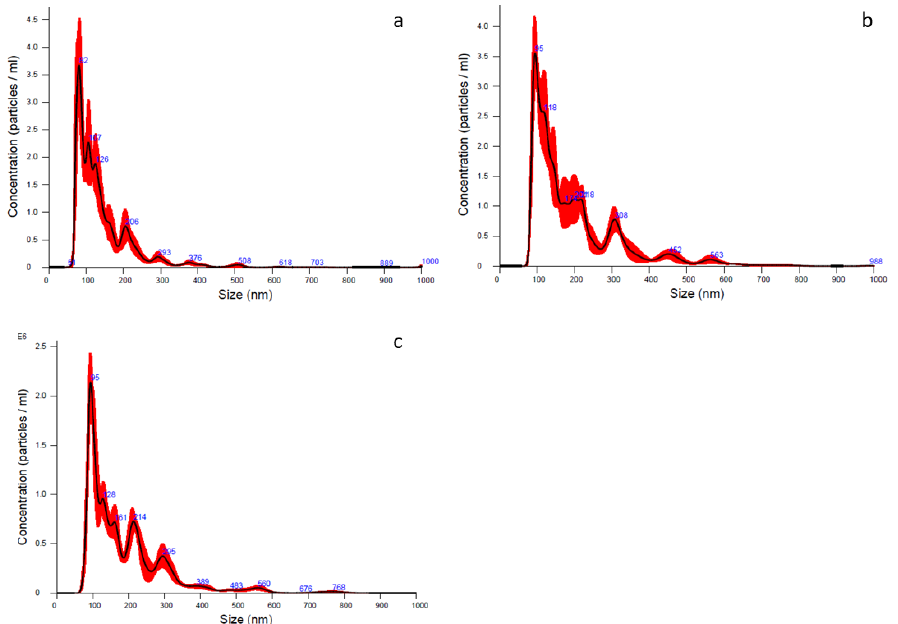
Figure 4. NTA analyses showing averaged particles concentration and size distribution of batch 1 (a), 2 (b), and 3 (c), respectively. The average of each batch was made by processing 6 cycles of 60 s each. The red part indicates the ± standard error of the mean values ( n = 3). Particles concentration is expressed as mean value ± standard deviation ( n = 3).